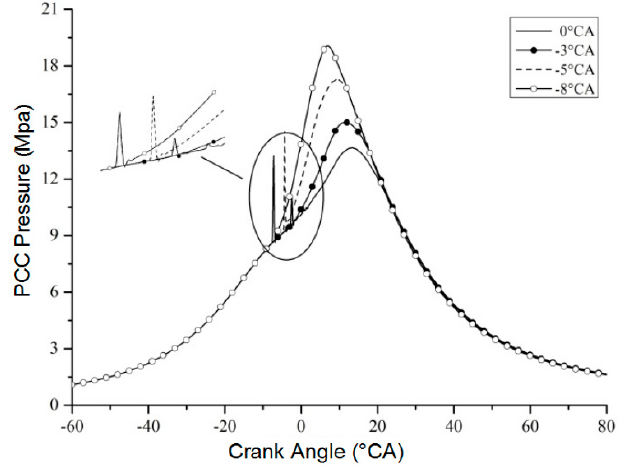
Figure 15. Mean in-cylinder PCC pressure at different pilot SOI timing.